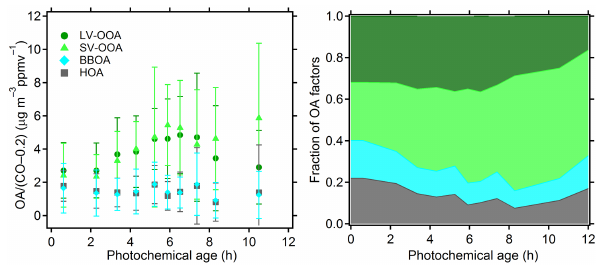
Figure 11. (a) The variations of LV-OOA /(cid:49) CO, SV-OOA /(cid:49) CO, BBOA /(cid:49) CO and HOA /(cid:49) CO with the photochemical age. The dot point and bar in each photochemical age bin are the average value and standard deviation. (b) Mass fraction of each OA compo- nent as a function of photochemical age. The photochemical age is classified into 10 bins by